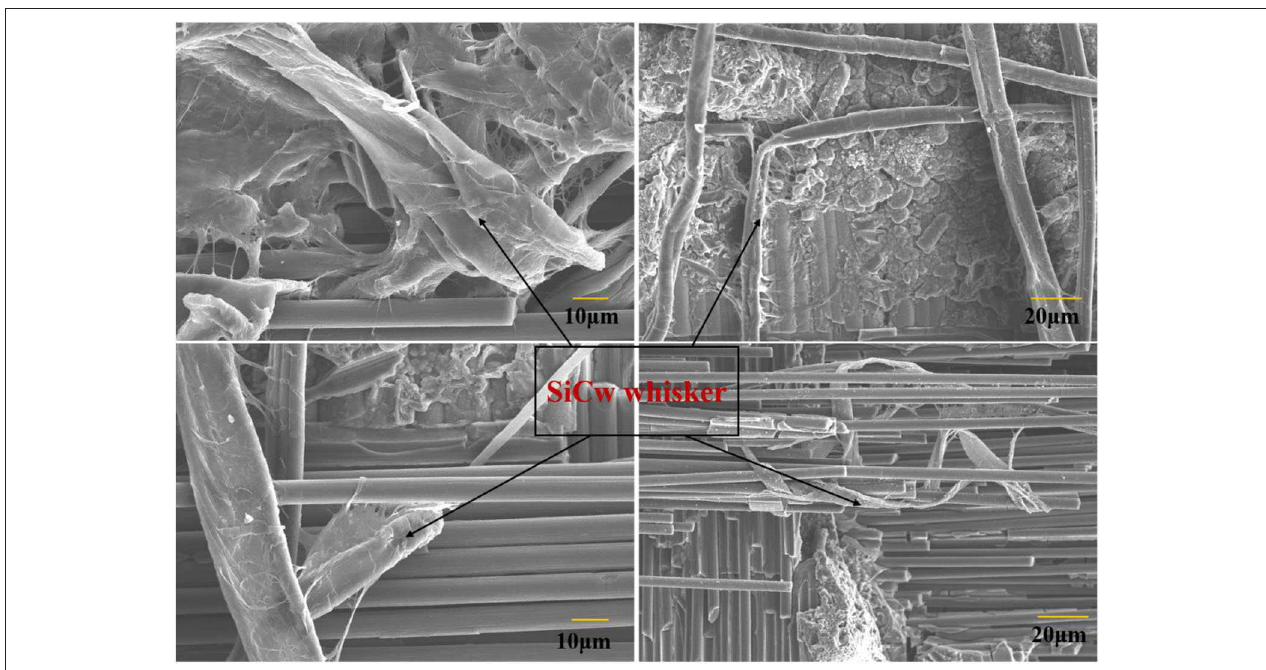
FIGURE 4 | SEM image of silicon carbide whiskers (SiCw) in the fracture surface of the of laser-assisted chemical vapor infiltration (LA-CVI)–continuous fiber-reinforced SiC ceramic matrix (C/SiC)–SiCw composite.